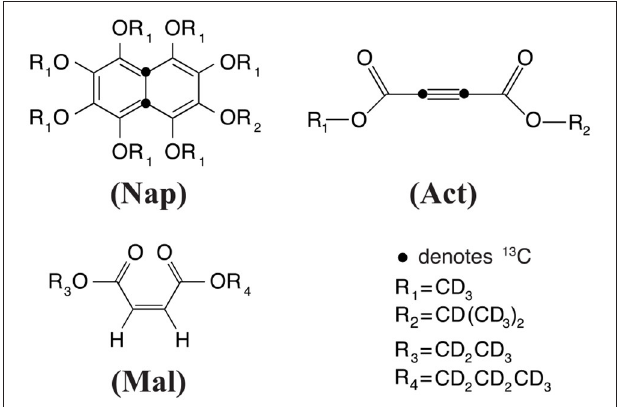
FIGURE 1 | Structure of the molecular systems employed in this